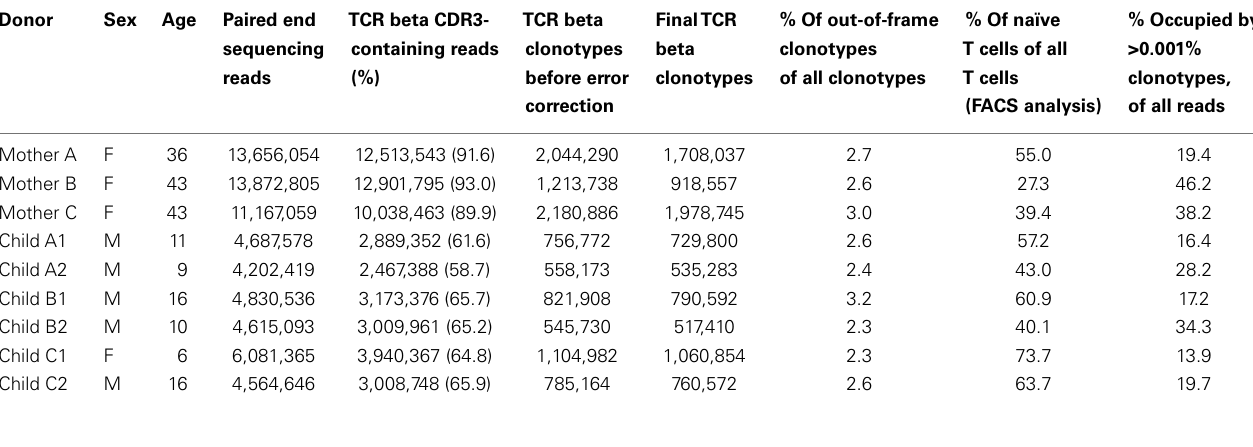
Table 1 | Sequencing results:TCR beta reads and clonotypes